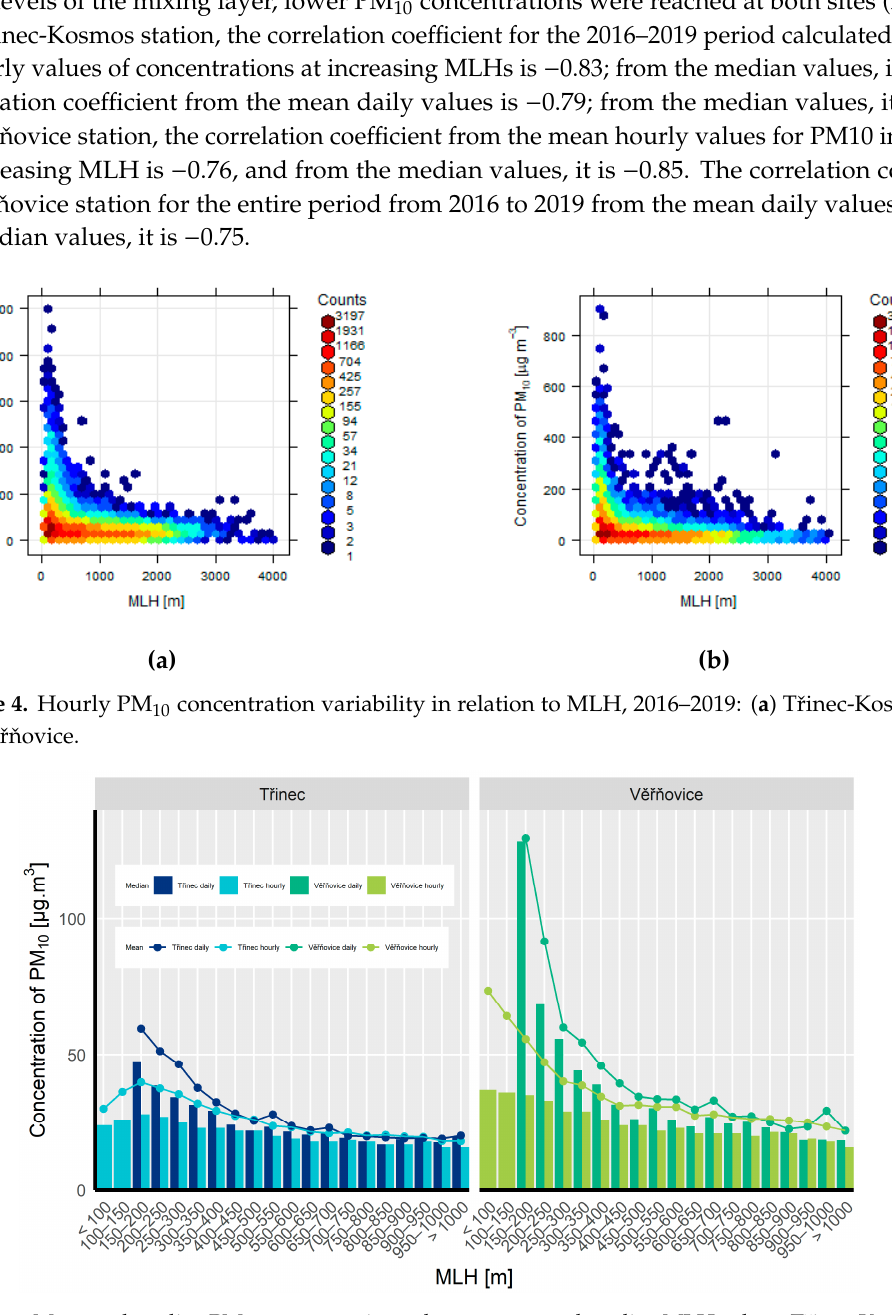
Figure 5. MeanandmedianPM 10 concentrationvaluesatmeanandmedianMLHvalues, Tˇrinec-Kosmos, Figure 5. Mean and median PM 10 concentration values at mean and median MLH values, T ř inec- Vˇeˇrˇnovice, Kosmos, V ěřň ovice, 2016–2019.